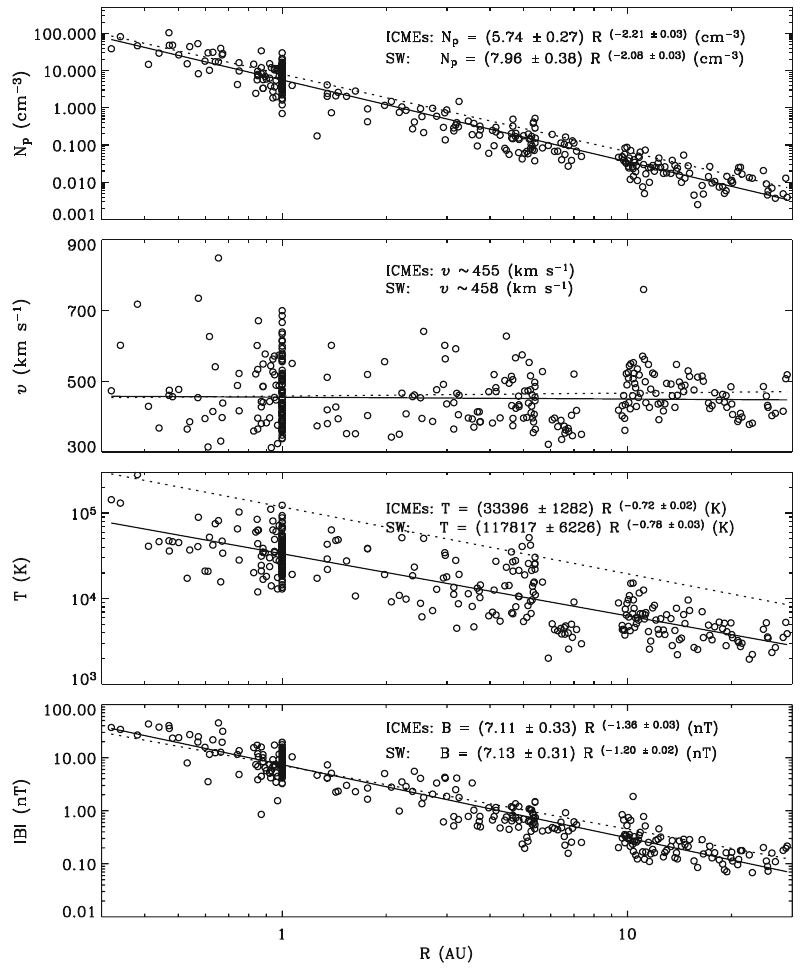
Fig. 27 The panels show from top to bottom the average solar wind density, speed, temperature and magnetic field magnitude as a function of heliospheric distance ( R ) from the Sun. Also shown are fits to the (solid)ICMEdataandfitstothe(dashed)ambient,i.e.,non-ICME,solarwinddata.Thedatapointscombine measurements from Helios 1 and 2, Wind, ACE, Ulysses and Voyager spacecraft. Image reproduced